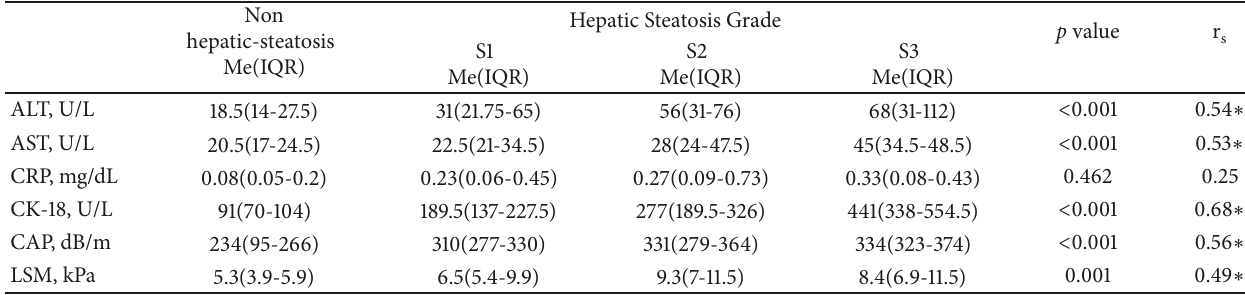
Table 4: Relationship between inflammatory markers, CK-18, fibroscan findings, and liver steatosis grade as assessed by US. Me, Median; r s : Spearmancoefficient correlation; ∗ : significant. ALT: alanine transaminase; AST: aspartate transaminase; CRP: C-reactive protein; CK-18: cytokeratin-18; CAP: controlled attenuated parameter; LSM: liver stiffness